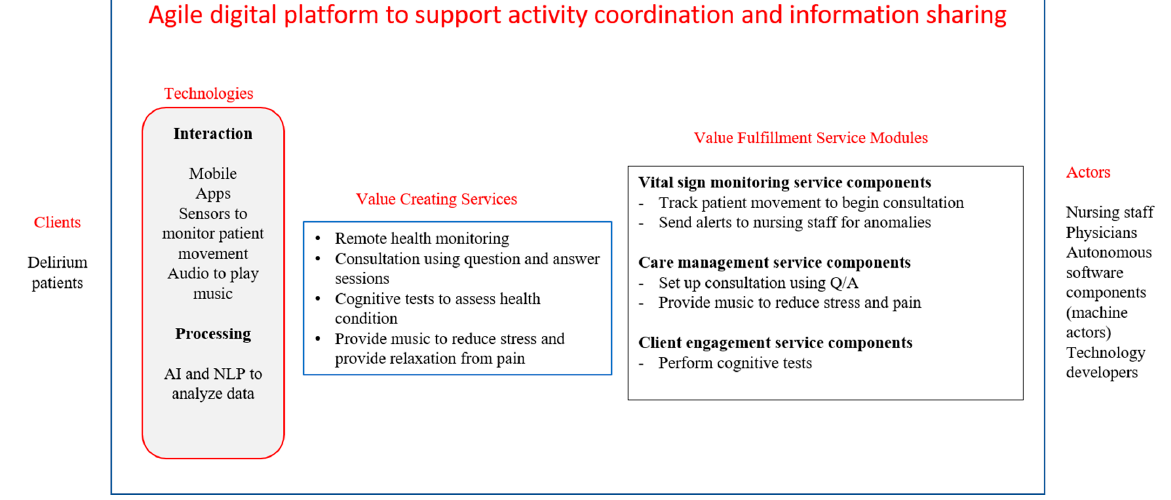
Figure 3. Digital platform to support delirium patients.